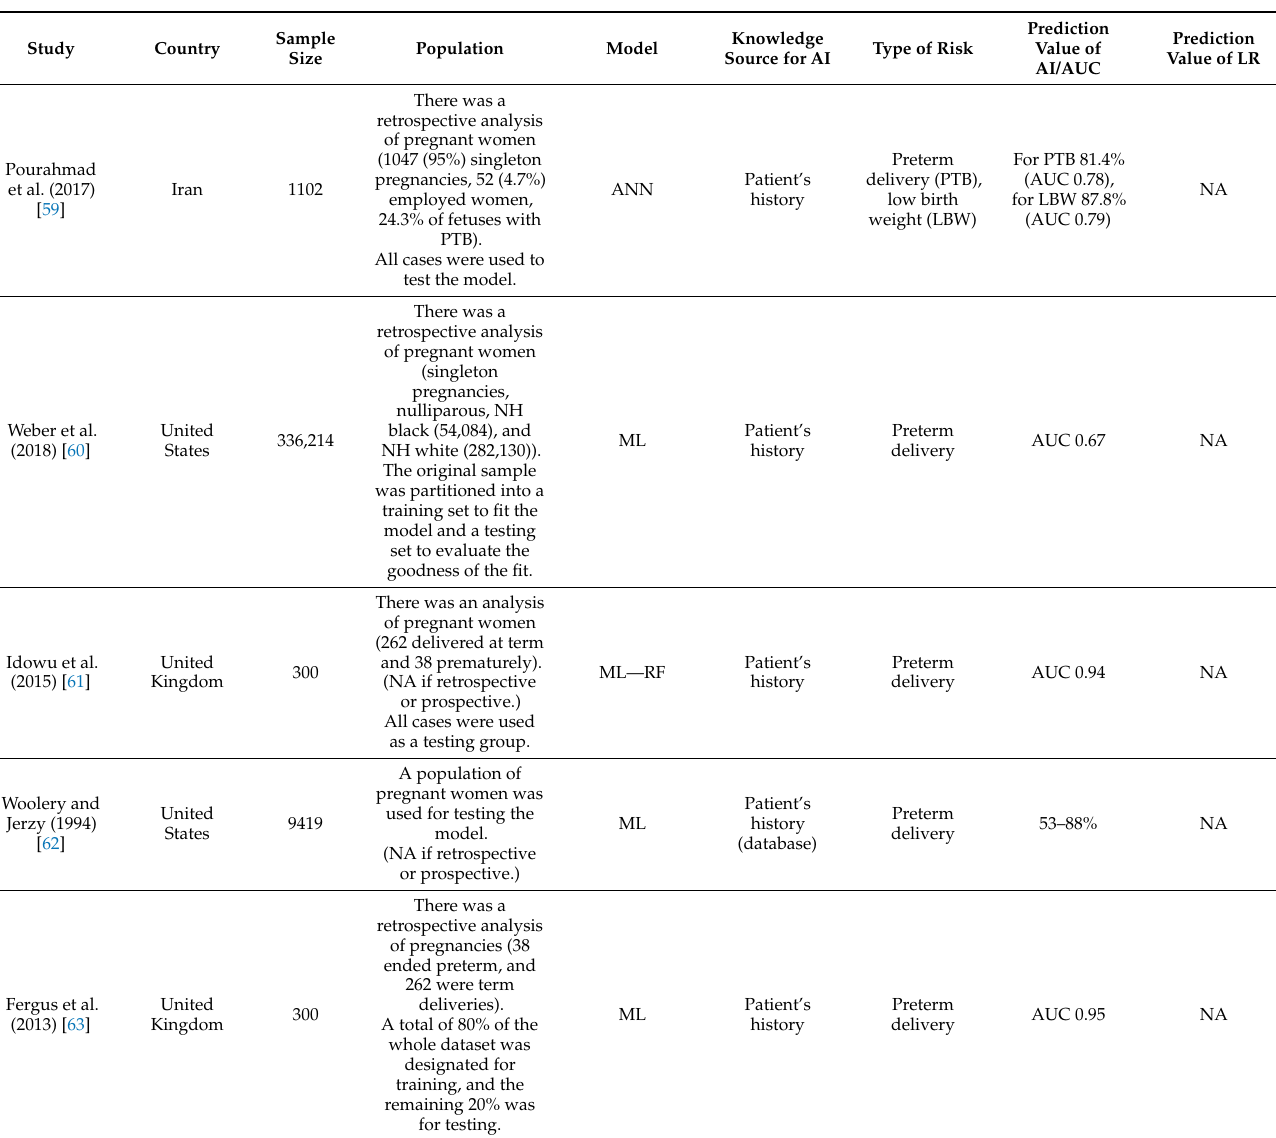
Table 8. Characteristics of included studies on preterm